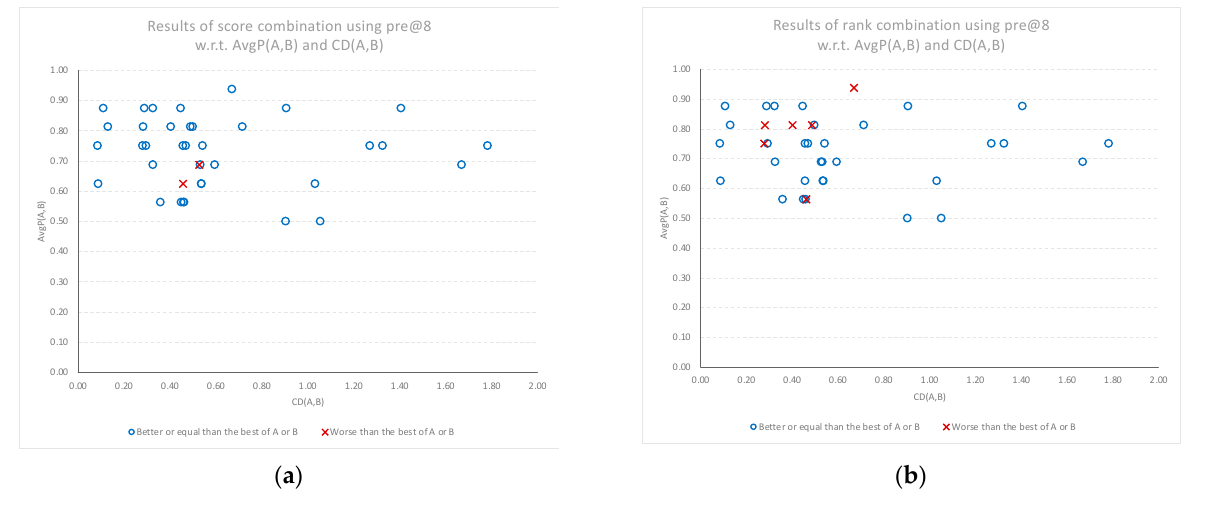
Figure 9. Relative performance of the combined models compared to the best of the individual models (best of A or B) for the top eight classifications, plotted against the average performance (AvgP) of the individual models and cognitive diversity. N = 38 documents. ( a ) Results when using score combination SC ( A , B ). ( b ) Results when using rank combination RC ( A , B ) .